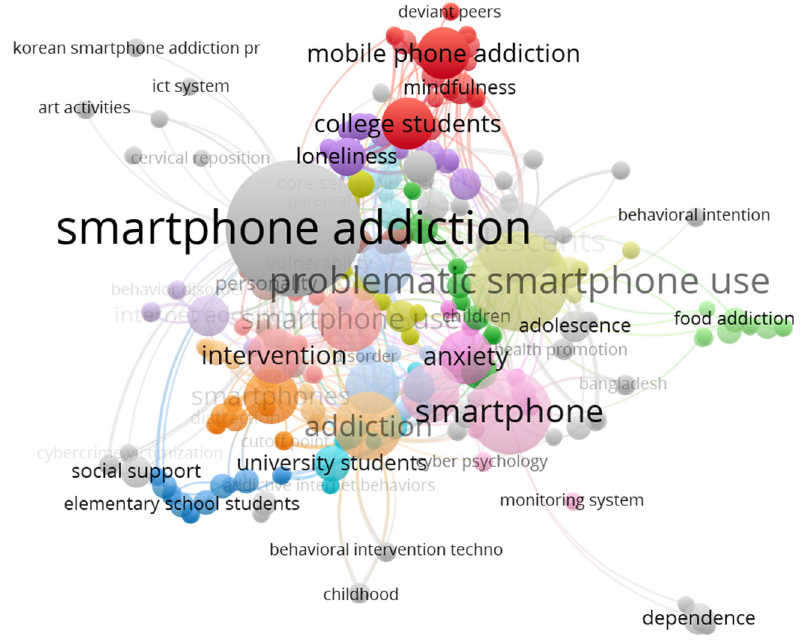
Figure 8. Co ‐ occurrence of authors’ keywords. Figure 8. Co-occurrence of authors’